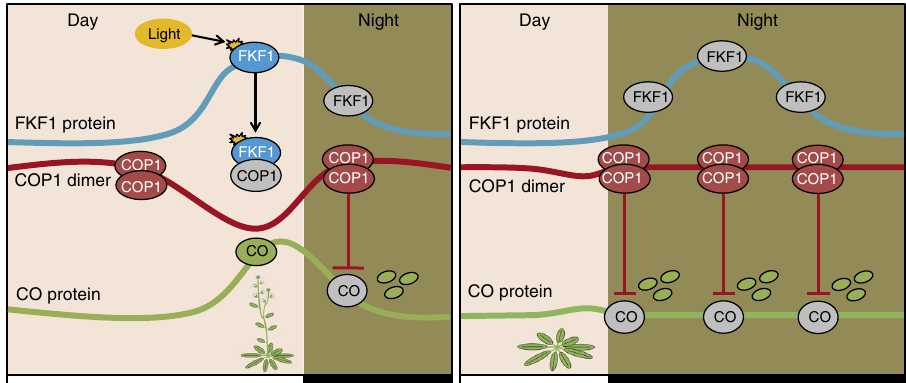
Fig. 6 Suggested model of photoperiodic fl owering through posttranslational regulation of CO by FKF1 and COP1. In LD (left panel), FKF1 protein is expressed in the afternoon and light-activated FKF1 interacts with COP1. The FKF1 – COP1 interaction inhibits COP1 dimerization, resulting in stabilization of CO and early fl owering. In SD (right panel), however, FKF1 protein is expressed after dusk and cannot interact with COP1 in the absence of light. Consequently, COP1 homodimers accelerate degradation of CO, resulting in late fl owering. In the multi-feedforward regulatory roles of FKF1 in Arabidopsis , the FKF1 – COP1 – CO regulatory cascade could play a pivotal role in optimizing the timing of fl owering under changing photoperiod